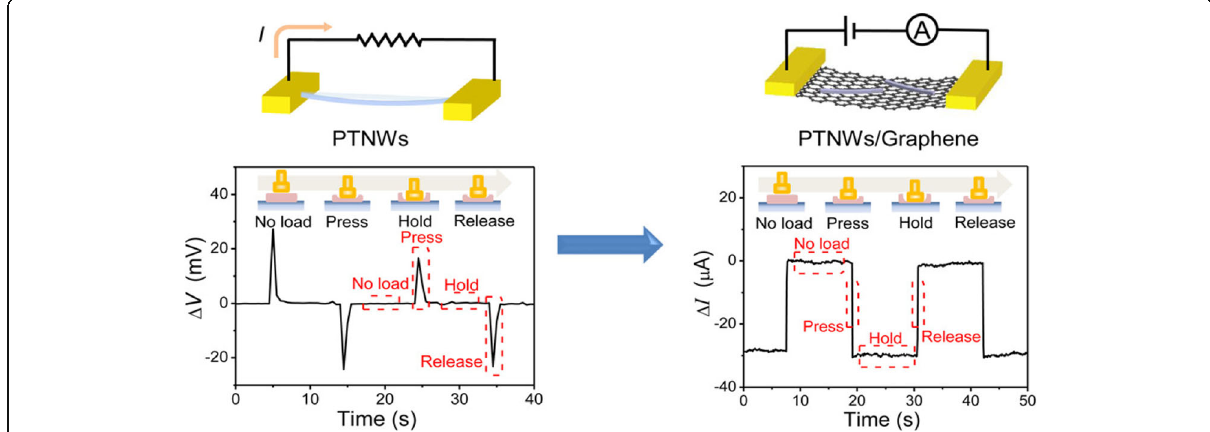
Fig. 6 Pressure response of PTNW-based pressure sensor (left) and of a PTNWs/graphene transistor under a pressure pulse. Adapted with permission from ref. 25. Copyright 2017 American Chemical